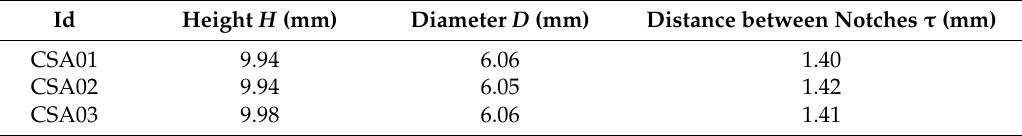
Table 5. Sample dimensions (dynamic case).